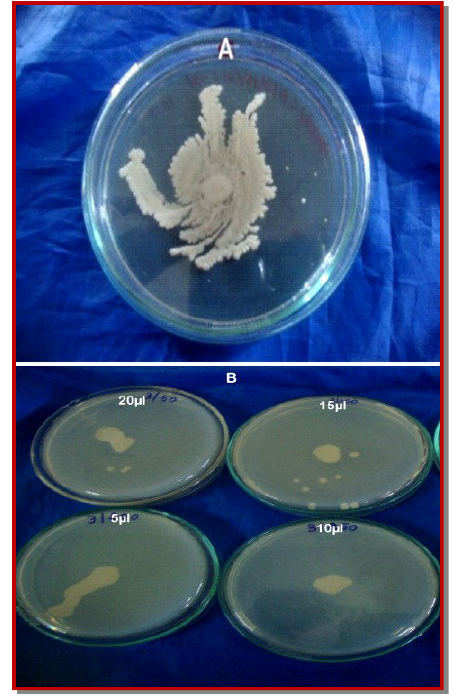
Figure 6: Swarming assay Swarming motility is dependent upon the agar% and concen- trations of AgNPs. (A) Control (Without AgNPs)-unorganized swarming. (B) Different concentrations (5, 10, 15, 20 µL) of